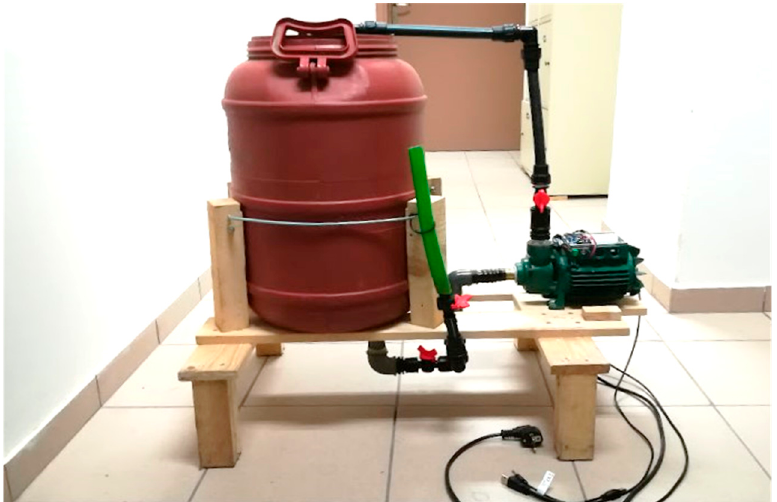
Figure 3. The implementation details for the proposed system, including a centrifugal water pump and three intervening plastic valves in the